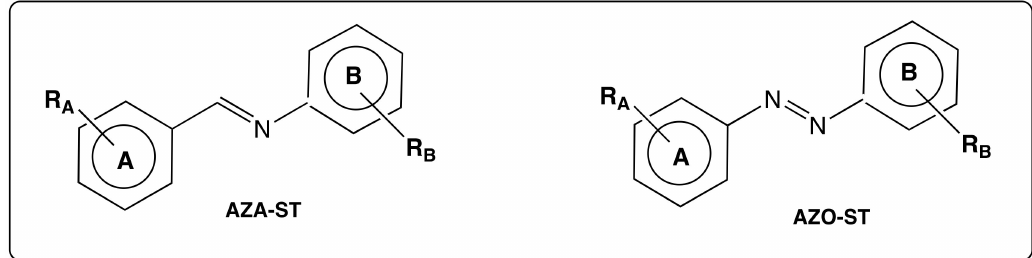
Figure 2. Structure of aza-stilbenes (AZA-ST) and azo-stilbenes